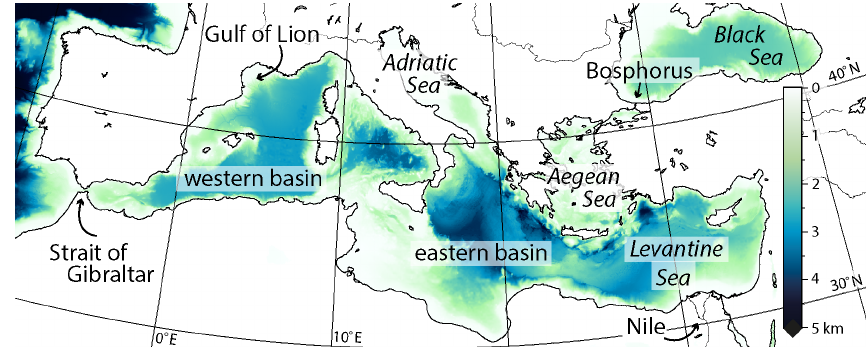
Figure 1. Map of the Mediterranean Sea. The bathymetry shown is part of the GEBCO 2014 grid. The colours indicate water depth.